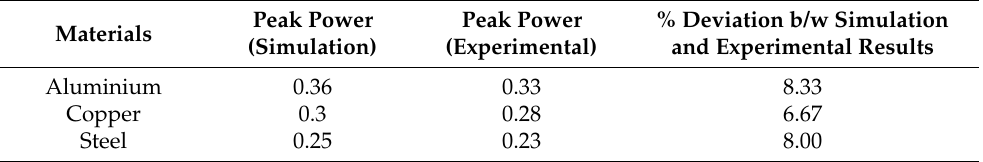
Table 4. Peak power data is for simulation and experimental results for the three bipolar plate